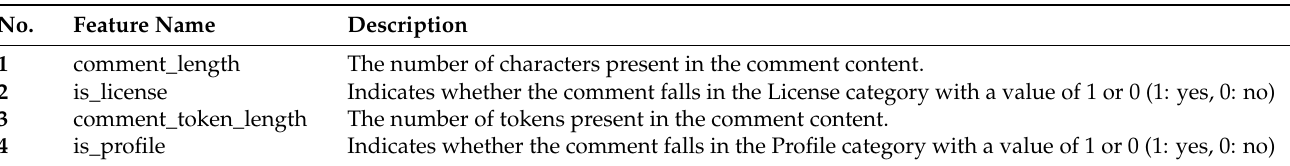
Table 5. New features introduced in the dataset during feature engineering